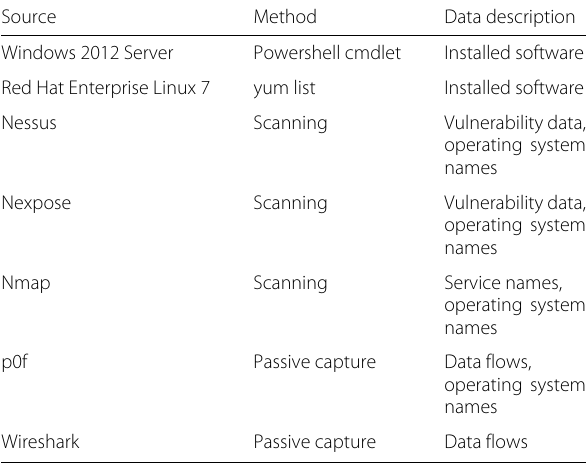
Table 1 Collected data and the different methods used for collecting the data. For each data source a separate data source specific adapter is created to parse the